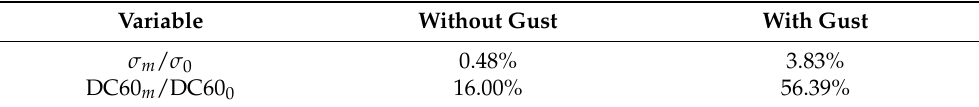
Table 5. Comparison of the maximum amplitudes of total pressure recovery and distortion fluctua- tions between the cases without/with gusts.